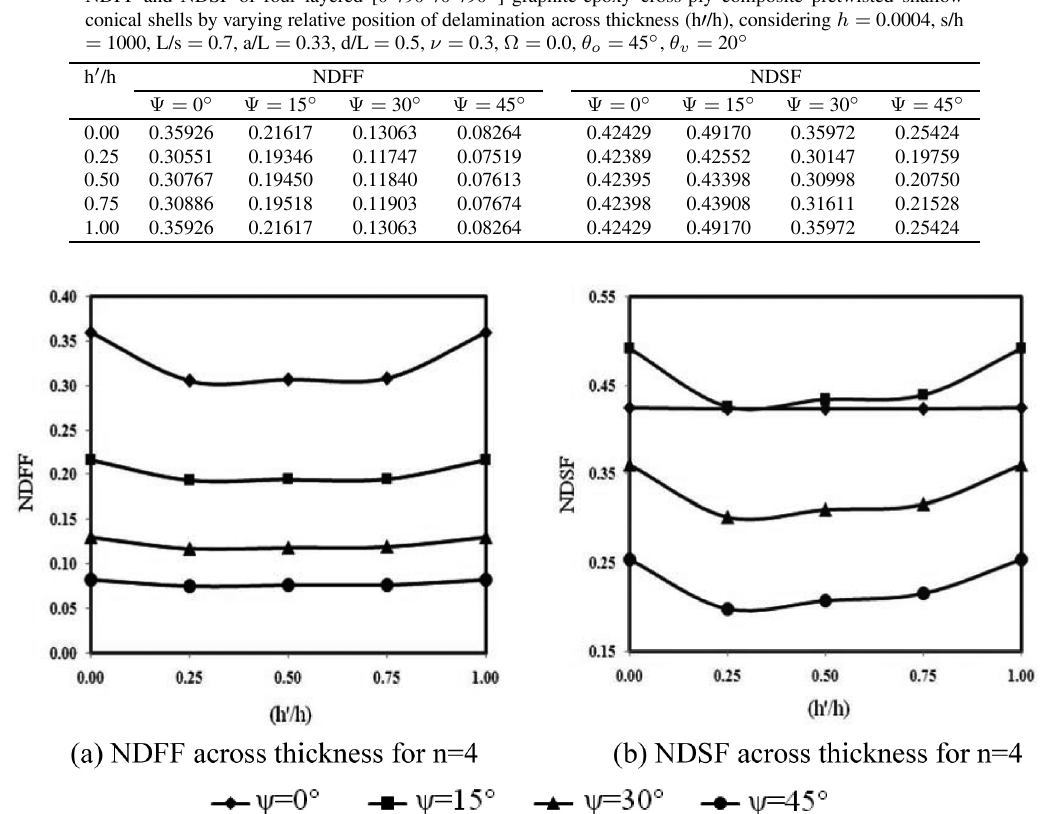
Fig. 4. (a) NDFF and (b) NDSF of four layered graphite-epoxy cross-ply [0 ◦ /90 ◦ /0 ◦ /90 ◦ ] composite pretwisted shallow conical shells with respect to relative position of delamination across thickness (h (cid:4) /h), considering a/L = 0.33, d/L = 0.5, h = 0.0004, s/h = 1000, L/s = 0.7, Ω = 0.0, θ o = 45 ◦ , θ v = 20 ◦